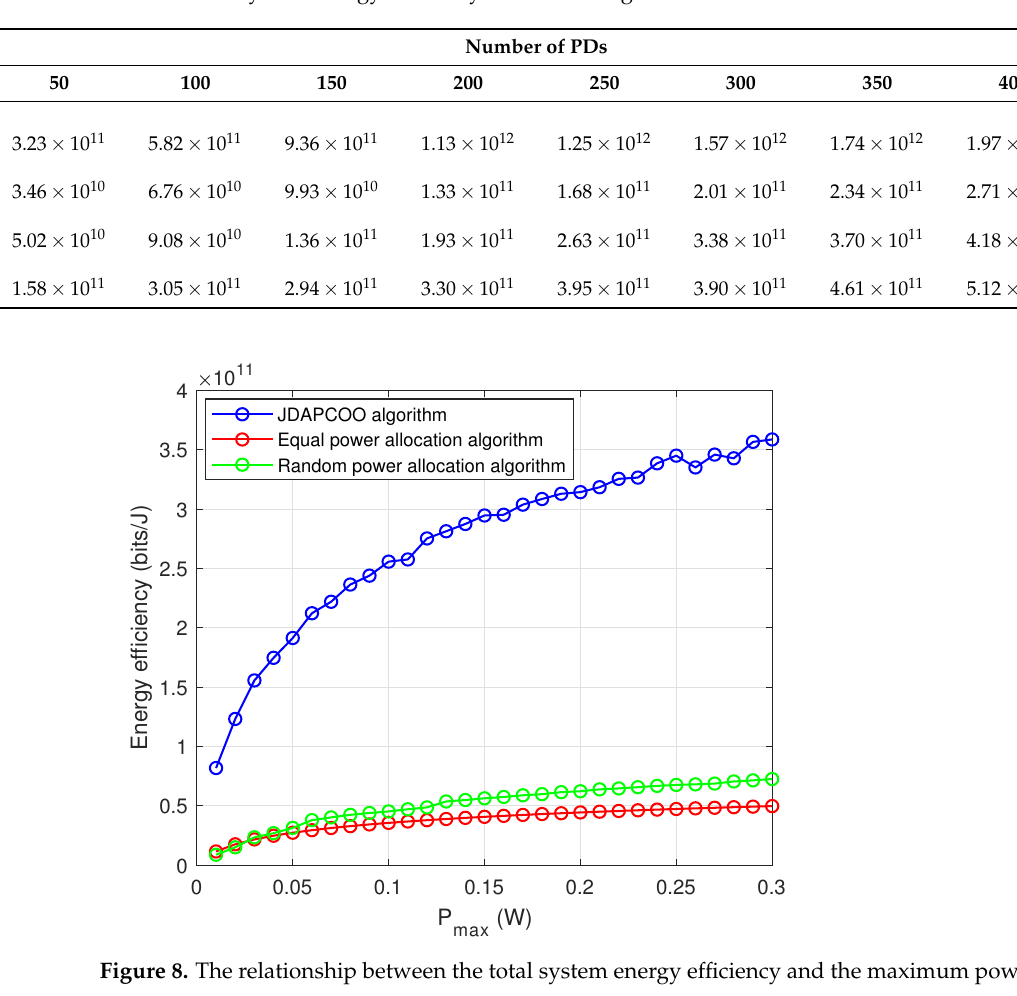
Table 4. Total system energy efficiency of different algorithms with different PDs.